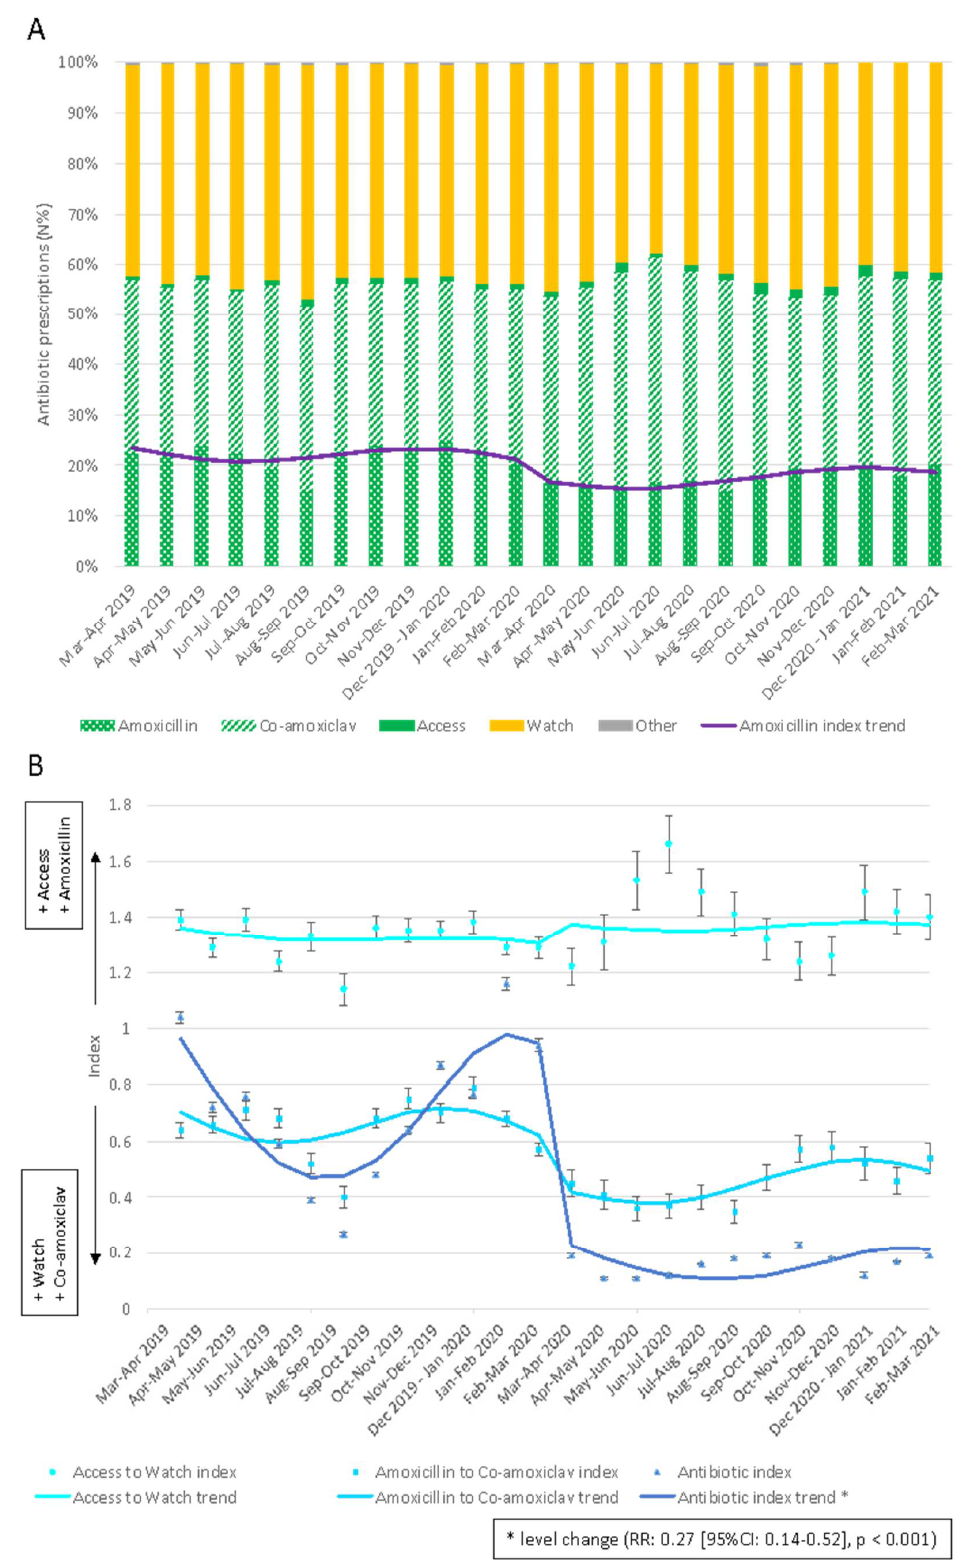
Figure 1. Monthly antibiotic prescriptions in children 0–14 years of age in Italy in the 12 months before and after the COVID-19 containment measures implementation ( A ) and interrupted time series of the monthly index ( B ) along with the 95% CI. Pedianet 2019–2021.